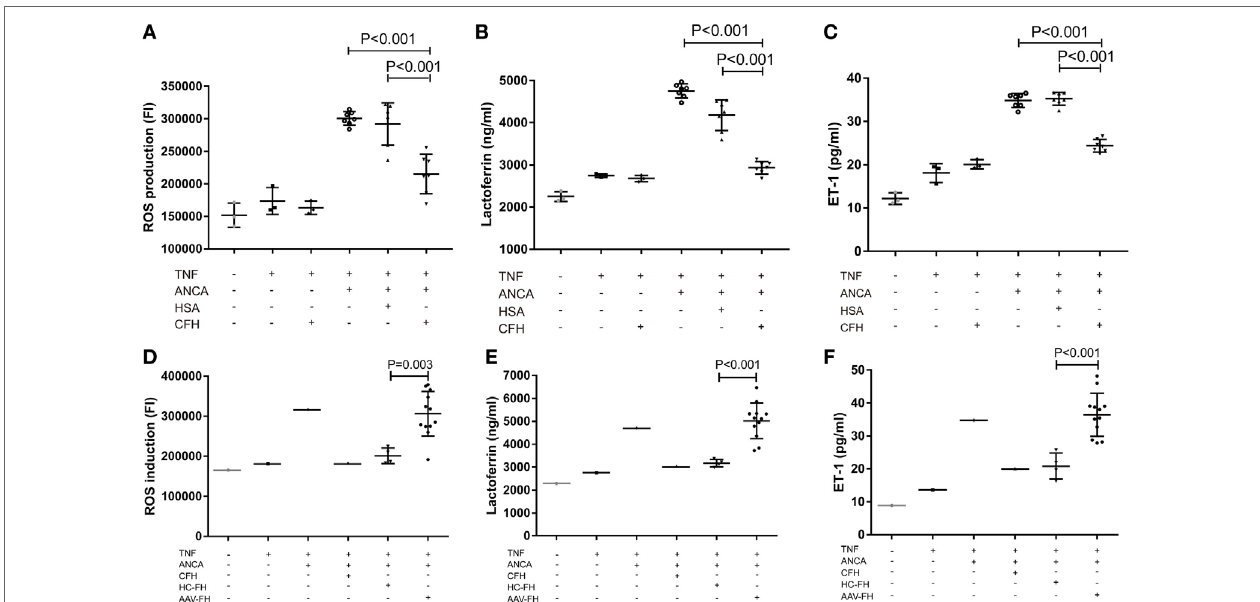
FigUre 5 | Factor H (FH) inhibits anti-neutrophil cytoplasmic autoantibody (ANCA)-induced neutrophil activation and endothelial injury in the coculture system of hGEnCs and neutrophils. Neutrophils primed with TNF- α were allowed to adhere on endothelial monolayers and followed by activation with myeloperoxidase-ANCA positive IgGs or proteinase 3-ANCA positive IgGs. (a) Pre-incubation of neutrophils with FH resulted in less production of ROS in the cocultures of hGEnCs and neutrophils. The values represent mean ± SD of ROS production derived from three independent experiments using ANCA-IgGs from seven different patients with ANCA-associated vasculitis (AAV). (B) The level of lactoferrin in the coculture supernatants was decreased by pre-incubation of neutrophils with FH. Shown is mean ± SD of three independent experiments. (c) The levels of endothelin-1 (ET-1) in the supernatant of cocultures decreased significantly when pre-incubating neutrophils with FH. (D,e) FH from patients with active AAV exhibited deficient ability in inhibiting the production of ROS and degranulation of lactoferrin by neutrophils cocultured with hGEnCs in the presence of ANCA, as compared with FH from healthy controls. Shown is mean ± SD of ROS and lactoferrin production by neutrophils pre-incubated with FH from different patients or controls, respectively. Experiments were independently repeated three times. (F) Compared with neutrophils pre-incubated with FH from healthy controls, the level of ET-1 in the coculture supernatants was significantly higher when neutrophils were pretreated with FH from patients with active